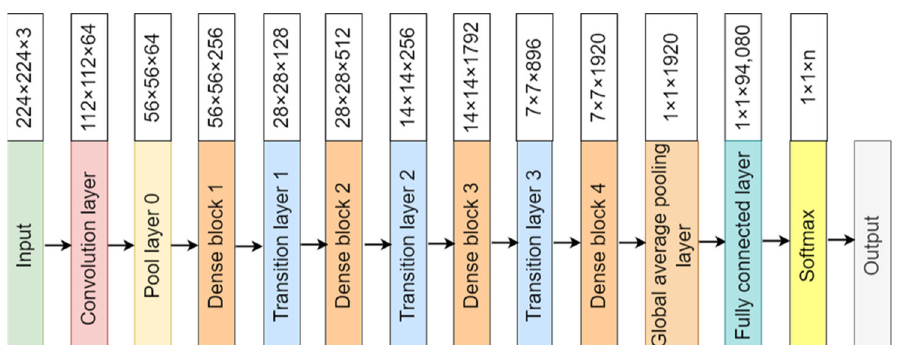
Figure 8. InceptionV3 architecture.